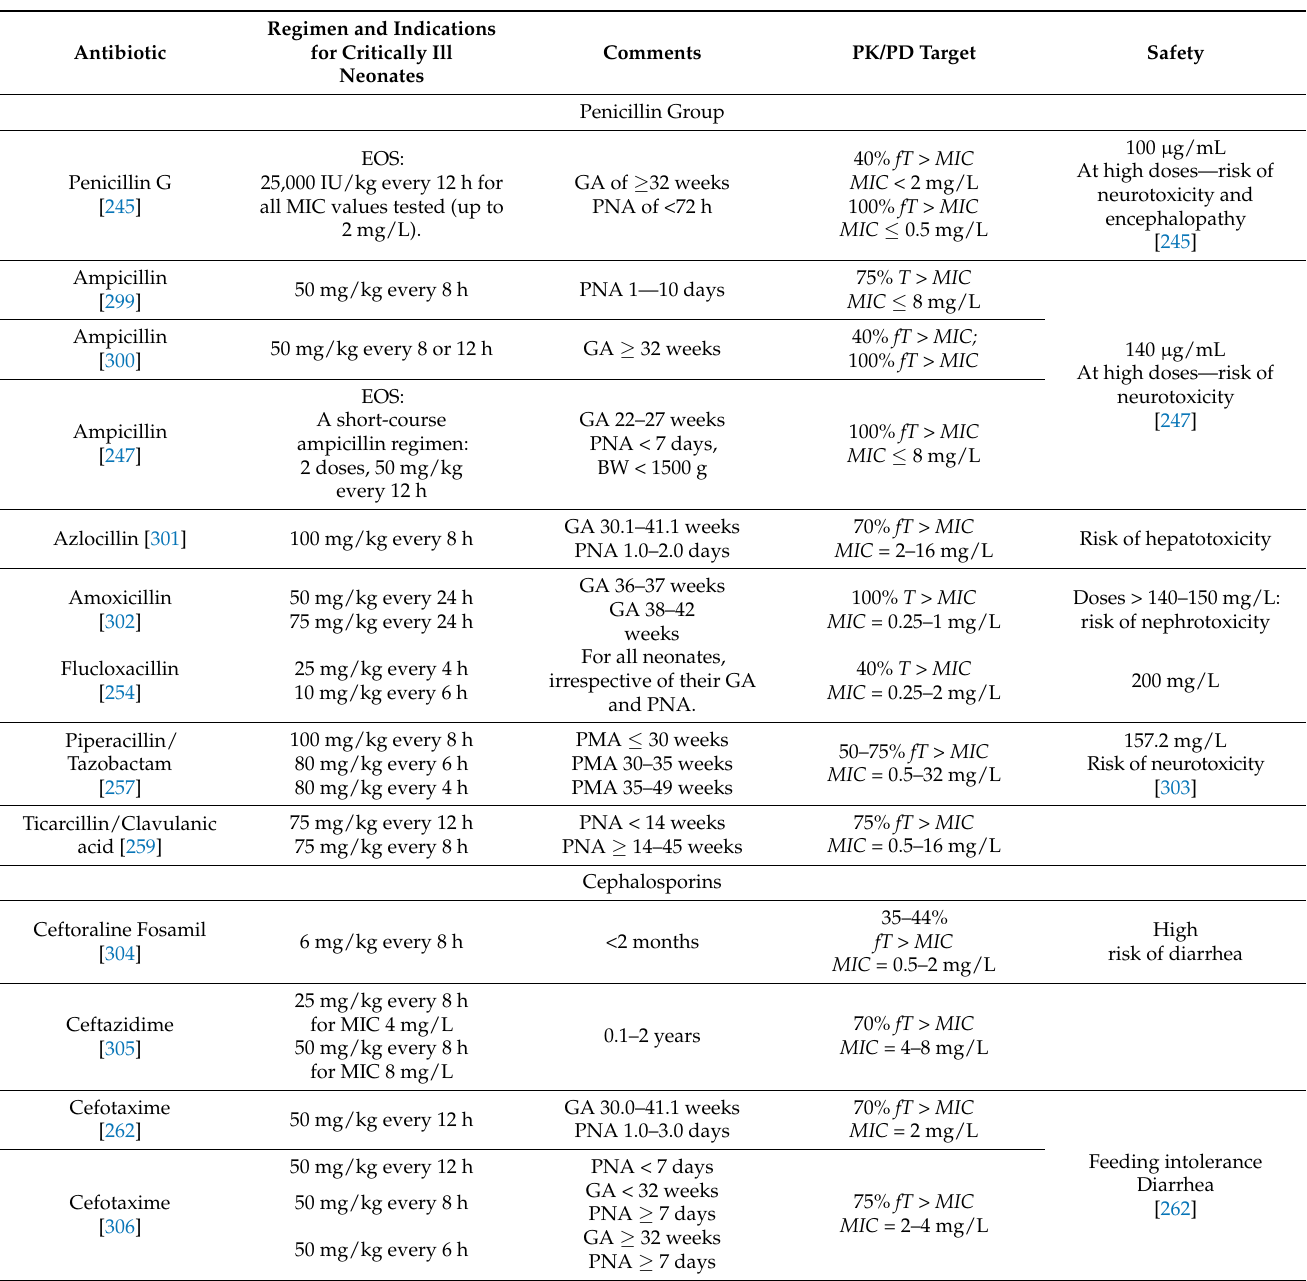
Table 10. Antibiotic dosing regimens in